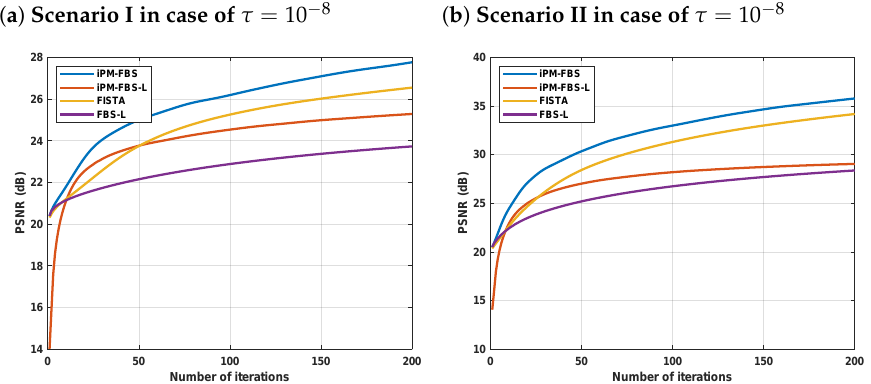
Figure 5. The PSNR comparisons of iPM-FBS, iPM-FBS-L, FISTA, and FBS-L